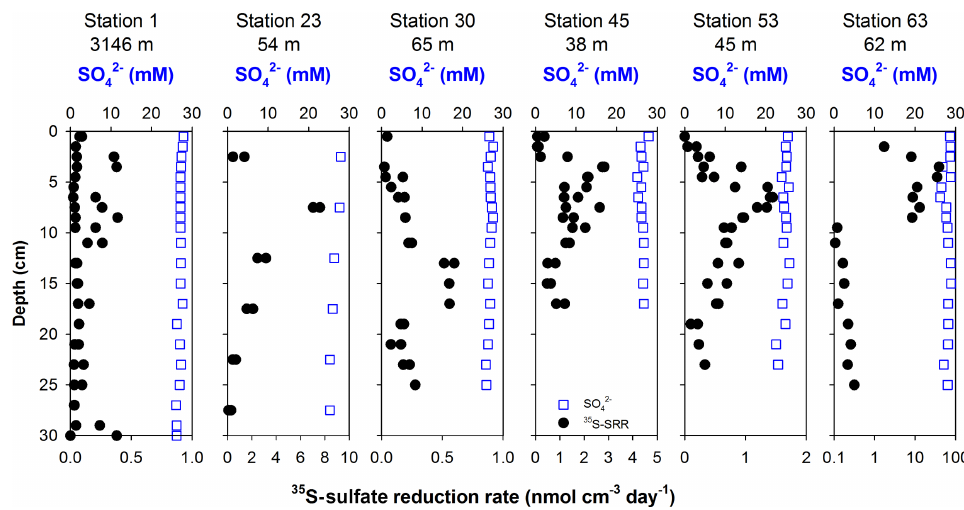
Figure 3. 35 S-SRR rates and corresponding pore-water sulfate concentrations for Stations 1, 23, 30, 45, 58, and 63.